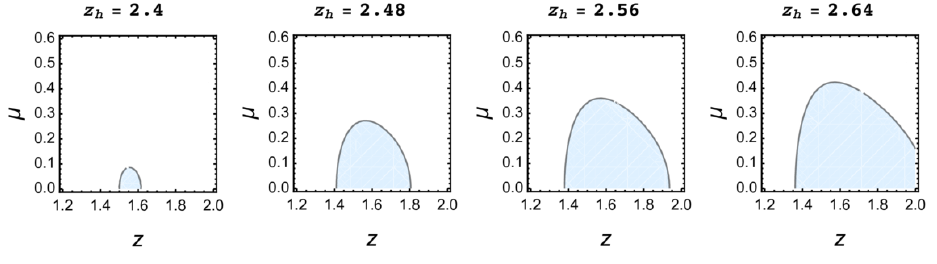
Figure 36 . Contour plots for DW x near zero for di(cid:11)erent z h (labels above).